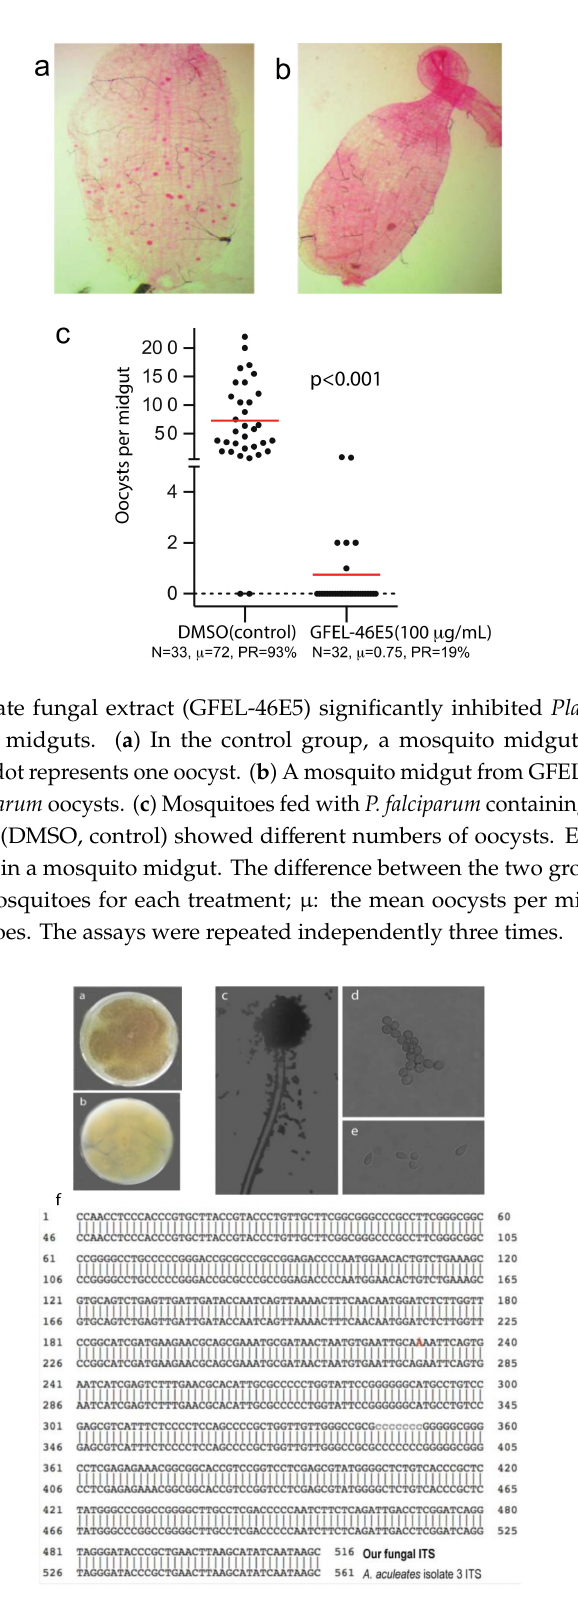
Figure 2. The candidate fungus GFEL-46E5 is an Aspergillus aculeatus isolate according to morphology and ITS (internal transcribed spacer) sequence. ( a ) Top view of the fungus colony on MEA; ( b ) Bottom view of the fungus on MEA; ( c ) conidial head; ( d ) subspherical conidia; ( e ) ellipsoidal conidia; and ( f ) ITS sequence aligns with the ITS of Aspergillus aculeatus isolate three from NCBI (Access #: